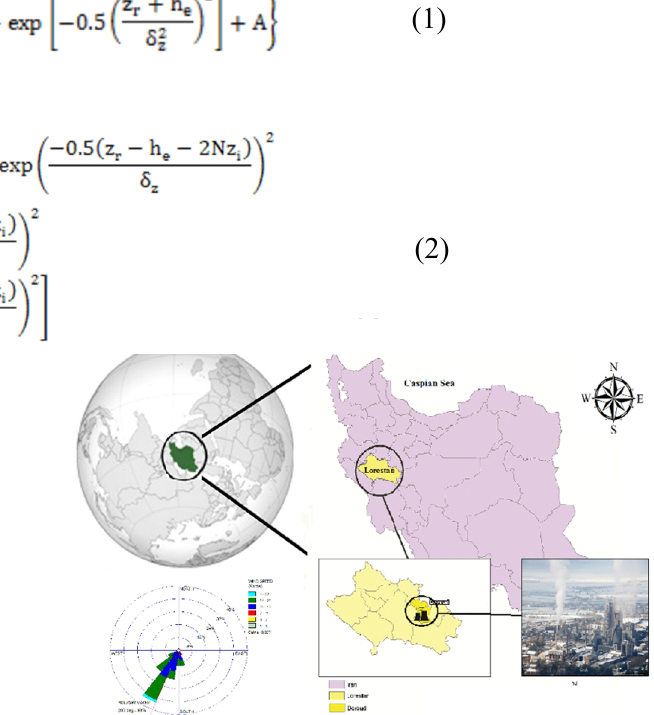
Figure 1. Doroud Cement Plant, the study